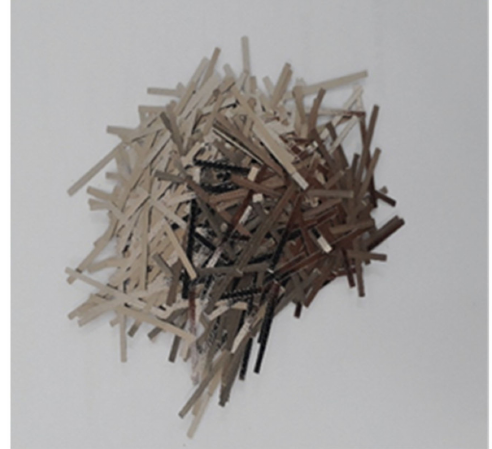
Figure 2. 30 mm-long metallic